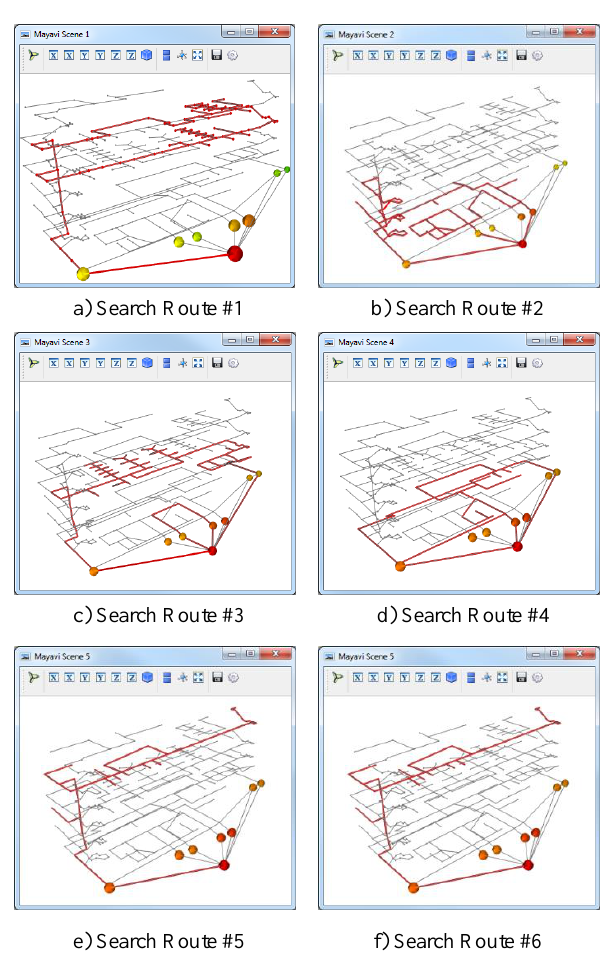
Figure 5. SRP Search Paths